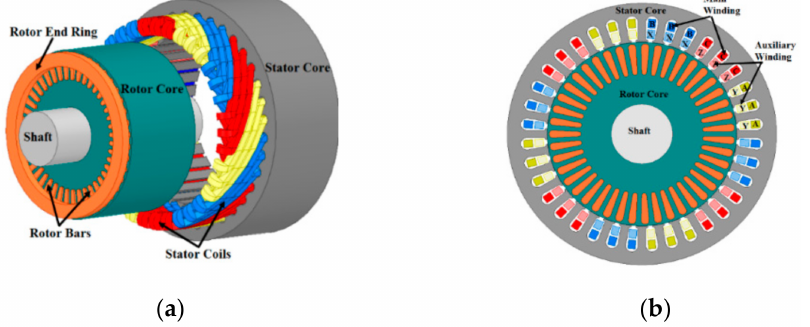
Figure 1. Configuration of the three-phase SCIM with auxiliary winding: ( a ) exploded 3D view; ( b ) 2D